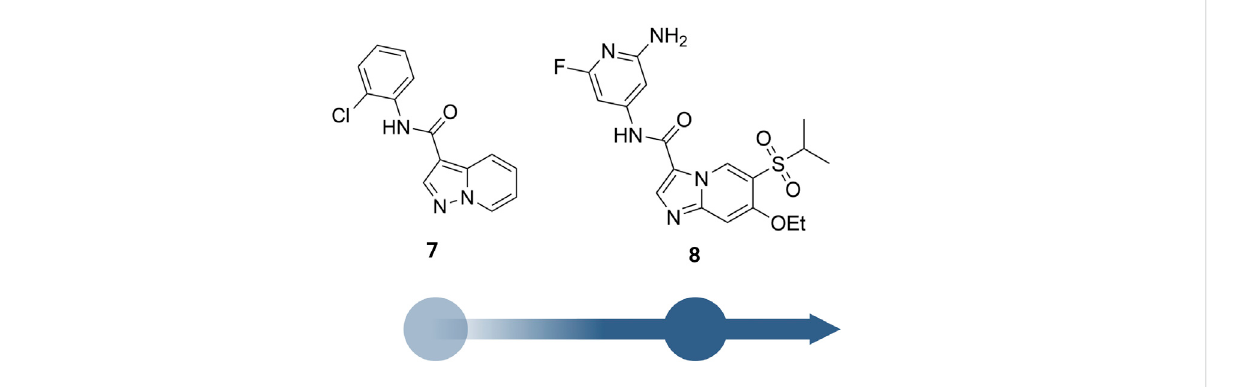
approach was utilized by introducing a phosphate group to the free hydroxyl of 4, leading to the phosphoric acid GSK2983559 and its salt forms with improved the compound ’ s solubility (Figure 6). After cleavage of the phosphate group in GI tract, the parent compound 4 was released and quickly absorbed. PK studies showed ef fi cient delivery of compound 4 after oral administration across species (Table 1). Meanwhile, the ef fi cacy of 4 was validated using biochemical, cellular, and tissue-based functional assays. All of them showed a high af fi nity of 4 toward RIPK2. In HEK293 cells overexpressed NOD2, 4 potently inhibited MDP-simulated production of IL-8 (IC 50 = 4 nM). In monocytes, TNF- α production was potently inhibited by (IC 50 13 nM). Prodrug GSK2983559 exhibited similar potency in biochemical assays